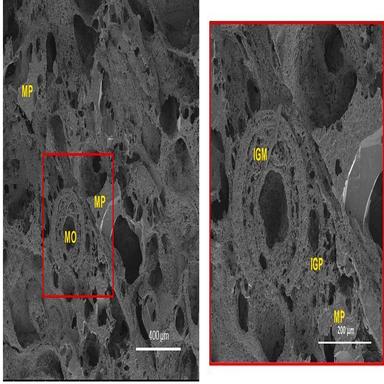
SEM images of the IL etched pore casts. Left: Macropores (MP) and microporous ooid (MO) are highlighted. Right: a higher magnification image highlighting the morphology and pore geometry of the well-connected IGM within the MO, and the intergranular porosity (IGP) interconnecting the MO with MP.